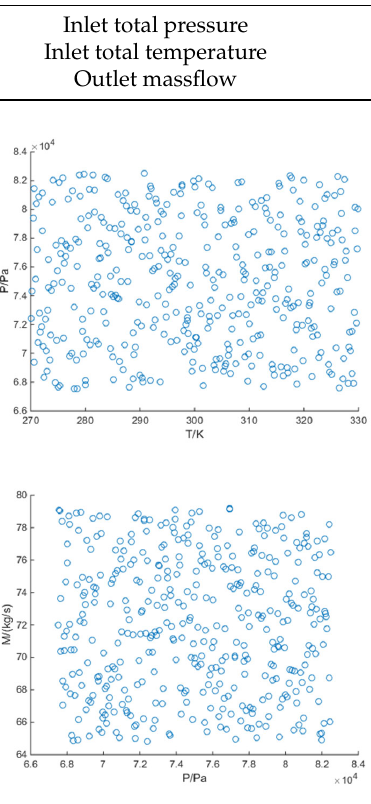
Figure 5. Data scatter